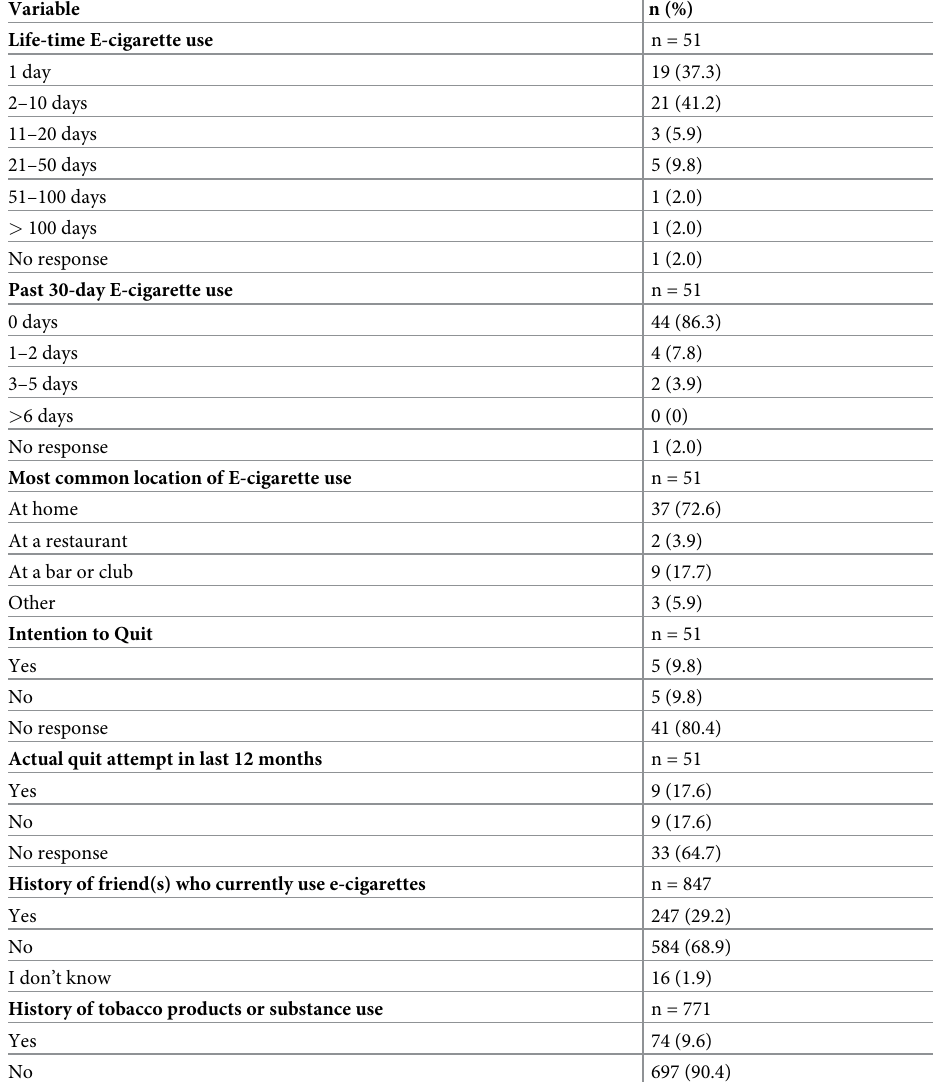
Table 2. Pattern of use and quit attempt among E-cigarette